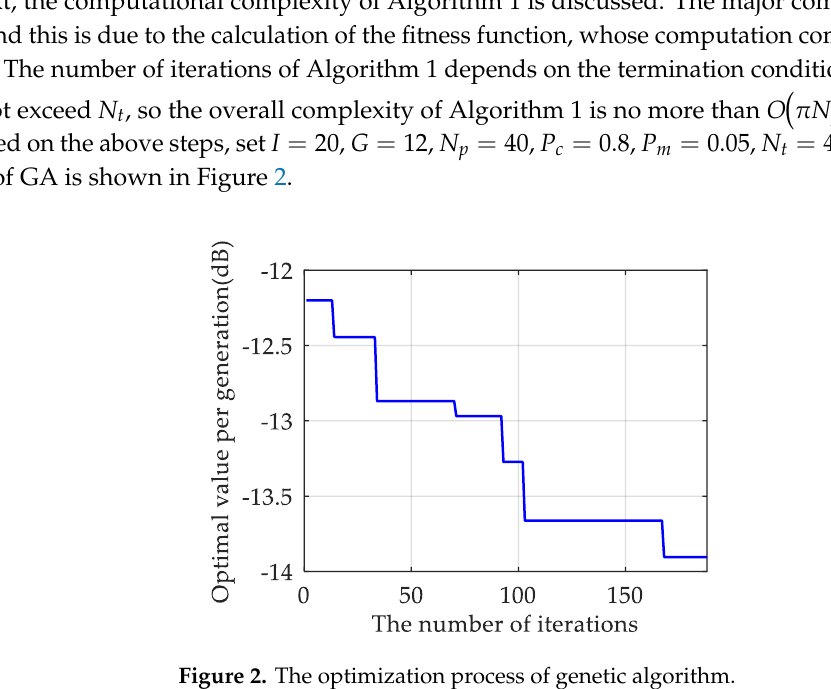
Figure 2. The optimization process of genetic algorithm.